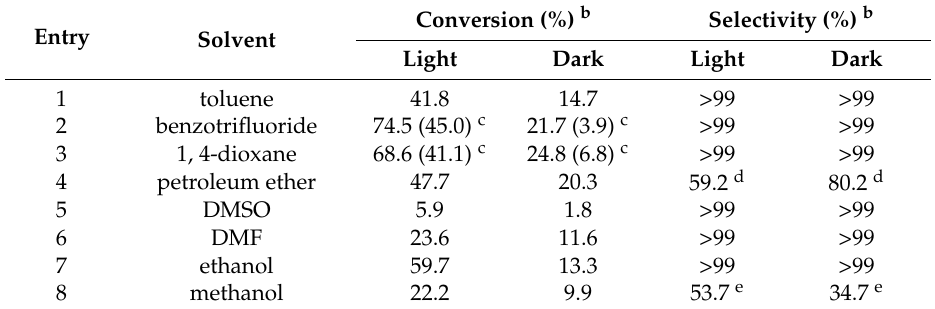
Table 3. Effect of the solvent on the aerobic oxidation of benzyl alcohol over 3 wt. % Au/Ni 3 Al HT a .